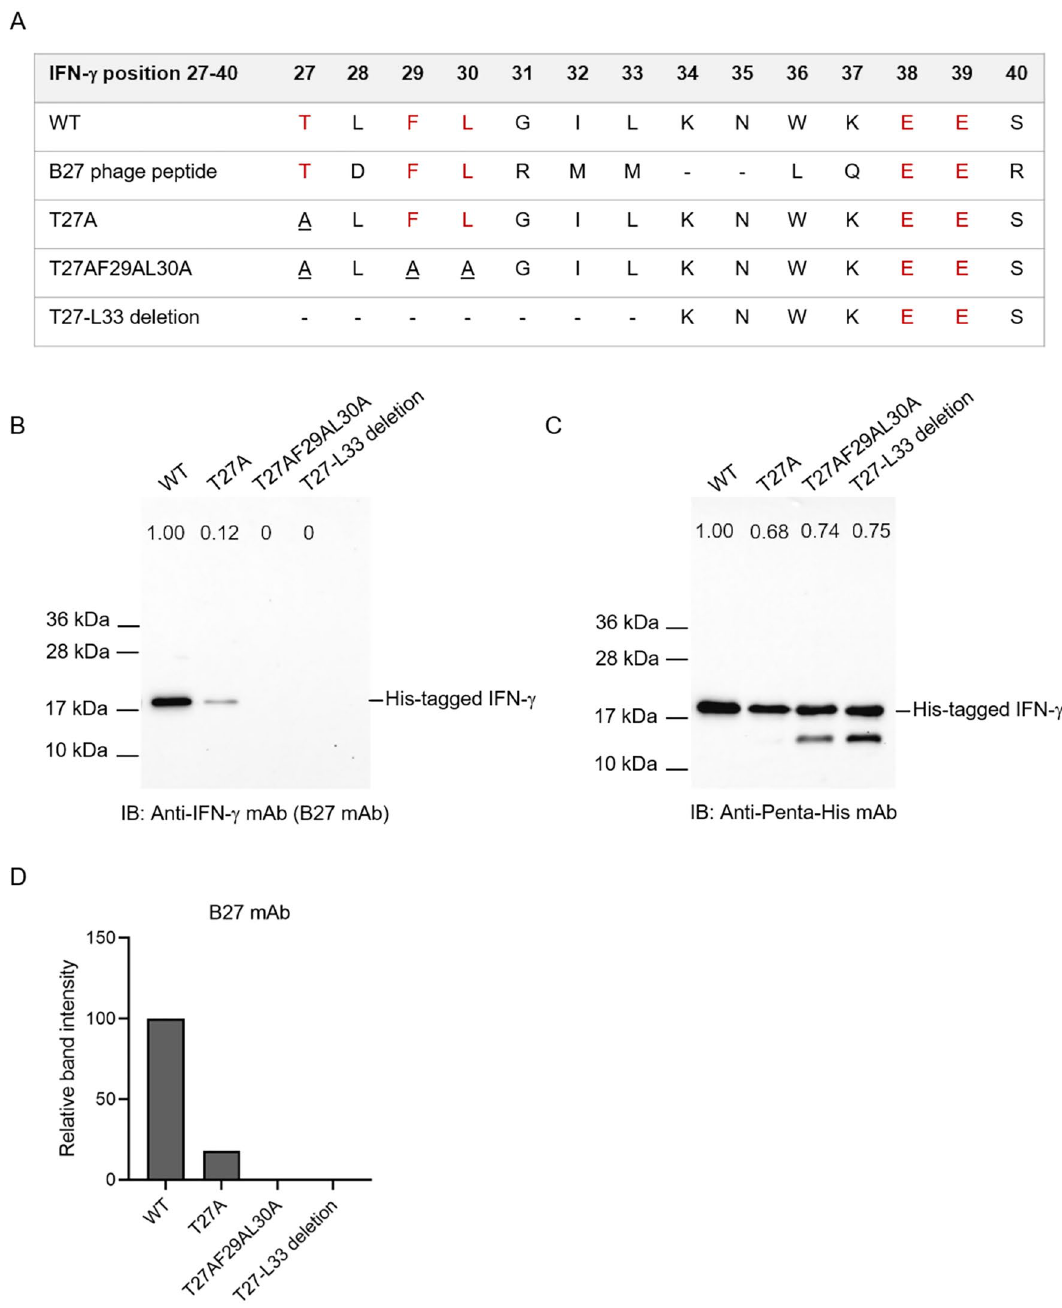
Figure 7. Binding activity of B27 mAb to IFN-γ WT and mutants using western blot analysis. ( A ) The amino acid sequence at positions 27–40 of IFN-γ WT and mutants. ( B ) Western blot analysis of B27 mAb concerning IFN-γ WT, T27A, T27AF29AL30A, and T27-L33 deletion. ( C ) Anti-Penta-His antibody was used to demonstrate the presence of each IFN-γ in bacterial soluble fractions. Band intensity of IFN-γ obtained by B27 mAb and anti-Penta-His antibody was quantified. The number represented the relative level of each IFN-γ mutant to WT. ( D ) Band intensity of IFN-γ detected by B27 mAb was normalized by those achieved by anti- Penta-His antibody. The normalized band intensity of IFN-γ mutants was compared with those in WT. Original blots are presented in Supplementary Figs. 4 and